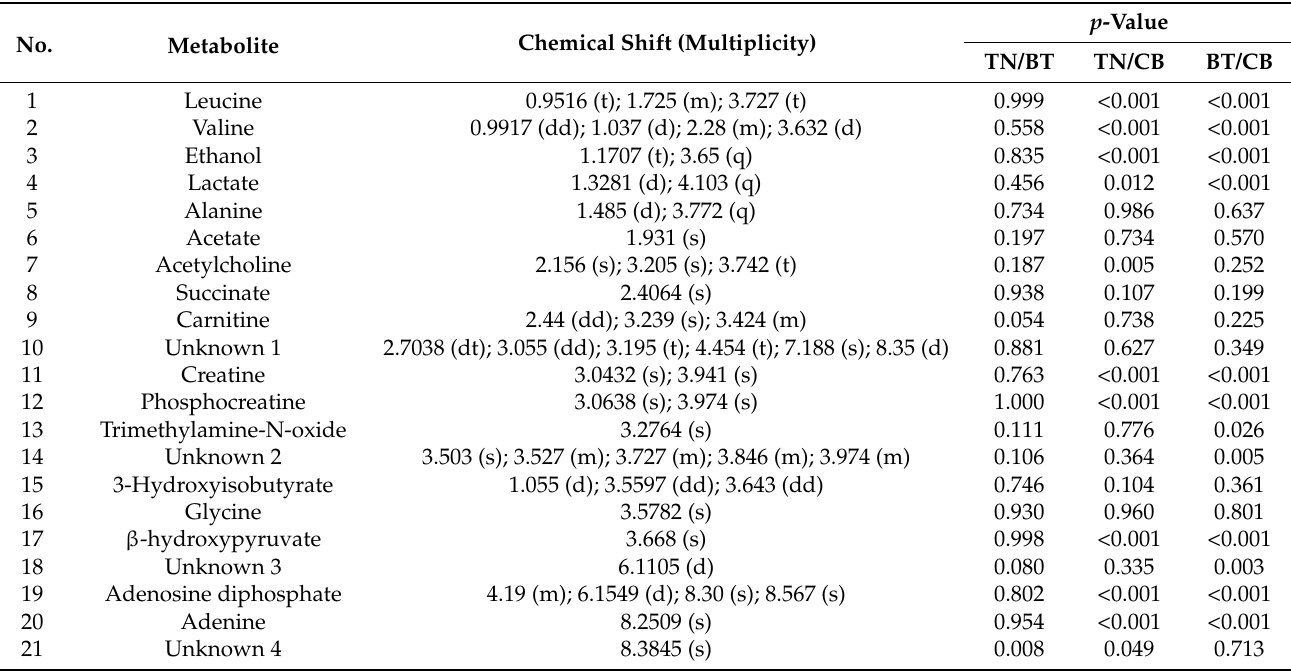
Figure 1. 1 H NMR CPMG median spectra of each group, metabolite names listed in Table 3. Table 3. List of metabolites, chemical shift, and their pair wise test.